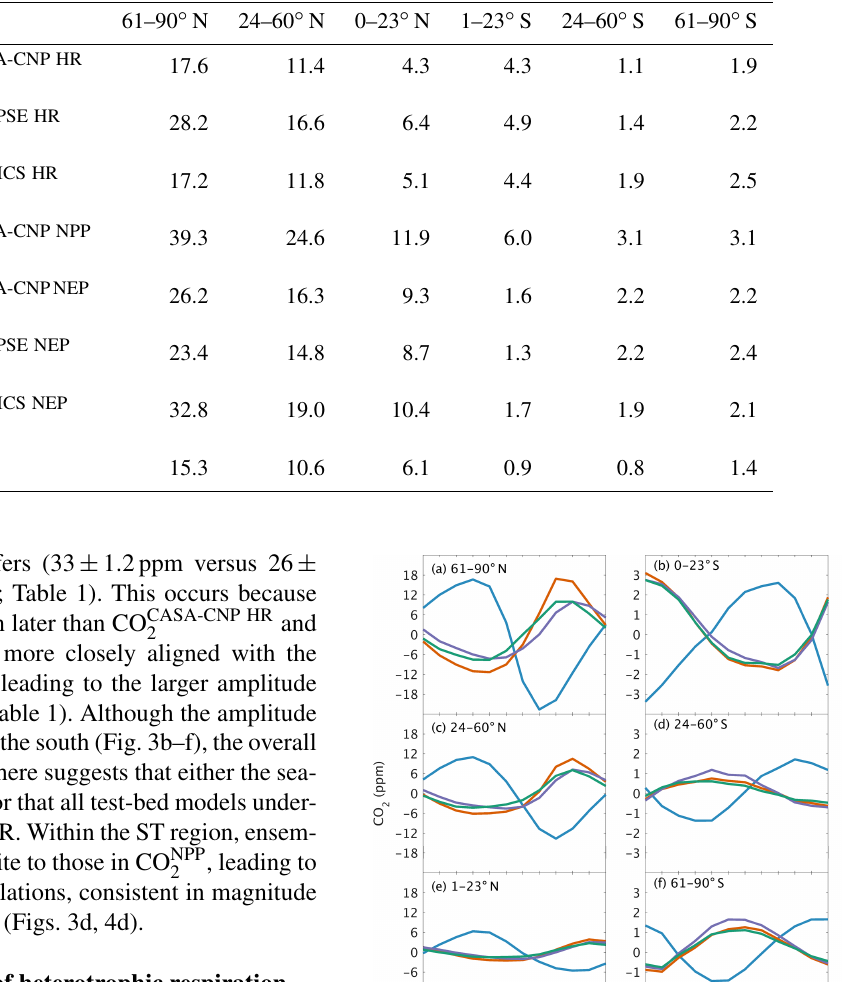
) averaged over latitude bands 2